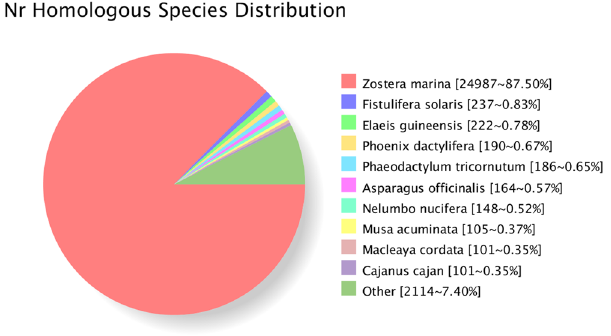
Figure 4. Homologous species distribution of Zostera japonica annotated in the NR database.